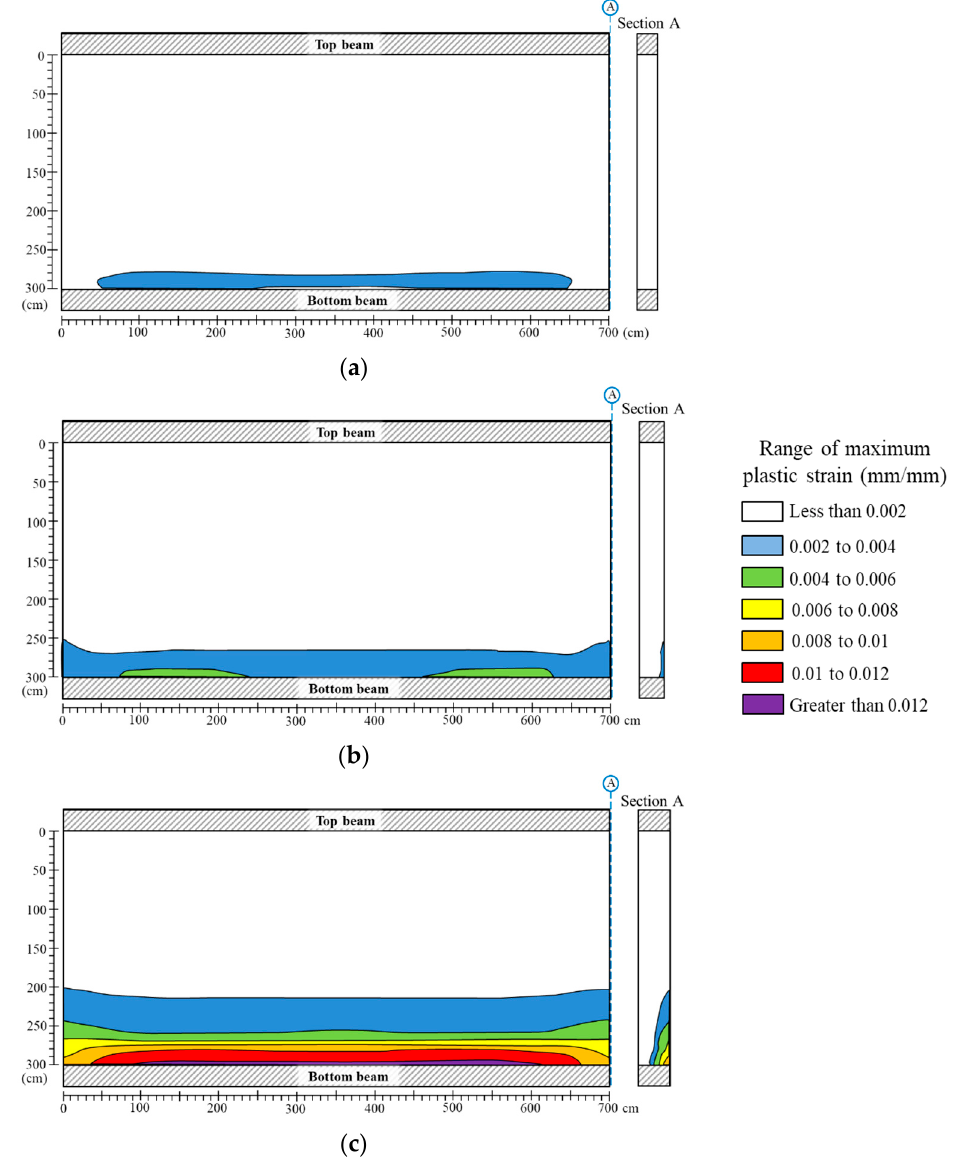
Figure 4. Maximum in-plane plastic strain distribution corresponding to the largest applied out-of-plane displacement for the dry wall in the interior wall face and in the cross section (A) at the wall edge for: ( a ) t = 25 cm, ( b ) t = 30 cm, and ( c ) t = 40 cm.